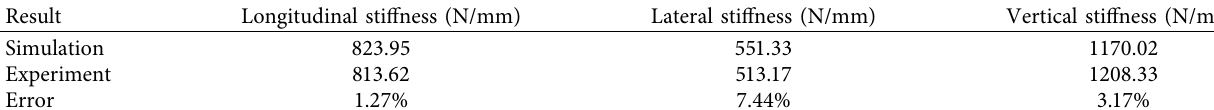
Table 6: Experiment and simulation tire stiffness results.